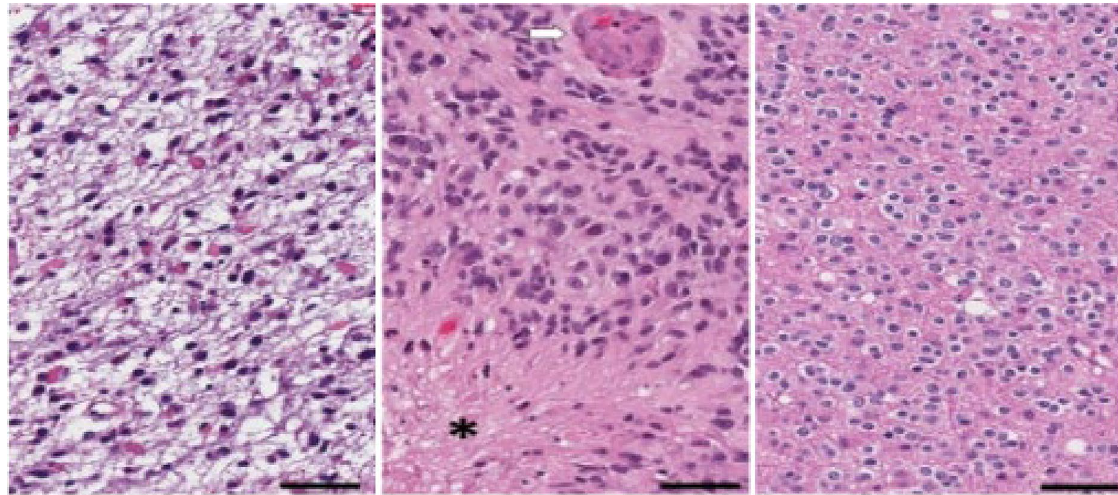
Figure 8. Pathological morphologies corresponding to each subtype of glioma. The scale bar at the bottom- right cornor indicates the actual size of 50 µm at the magnification. Left: astrocytoma (A). Middle: glioblastoma (G). Right: oligodendroglioma (O).